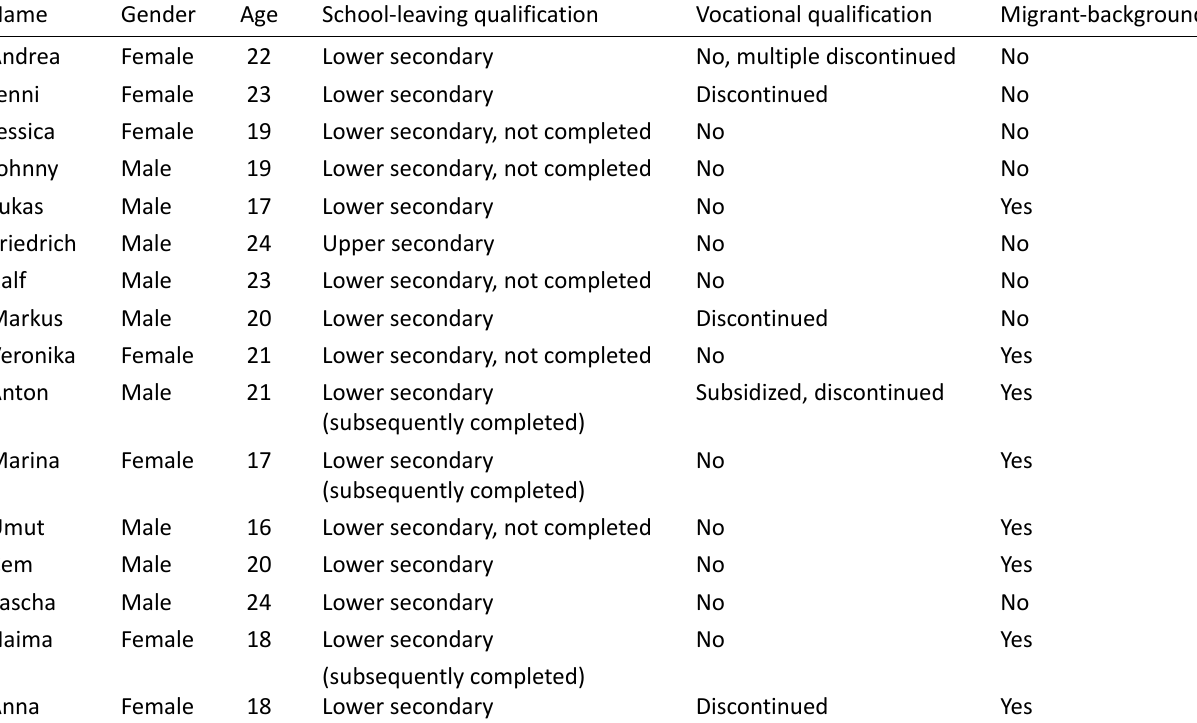
Table 1. Sample of longitudinal